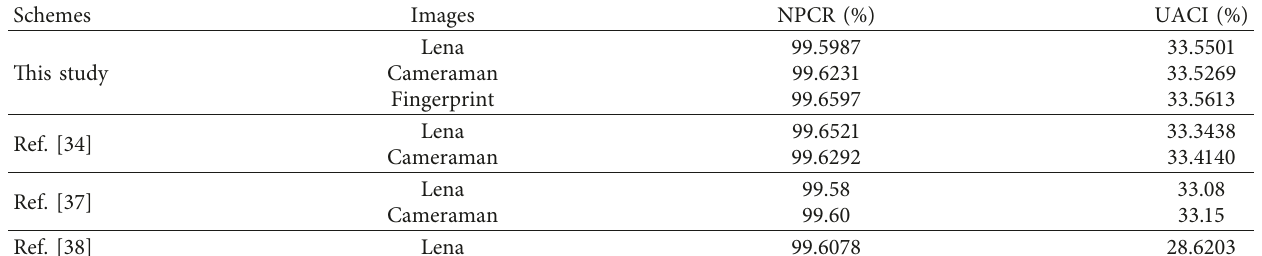
Table 5: NPCR and